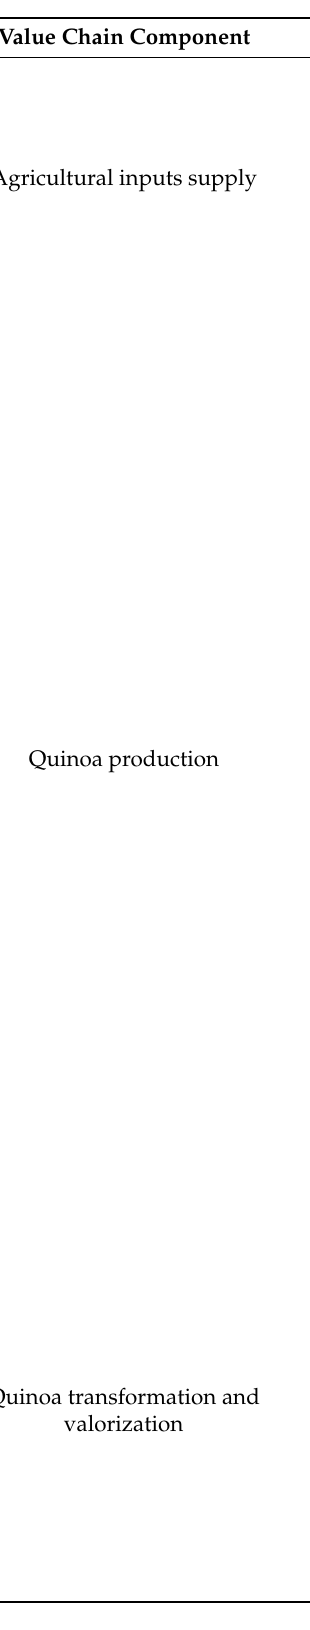
Table 10. Proposed development actions and involved actors for each value chain